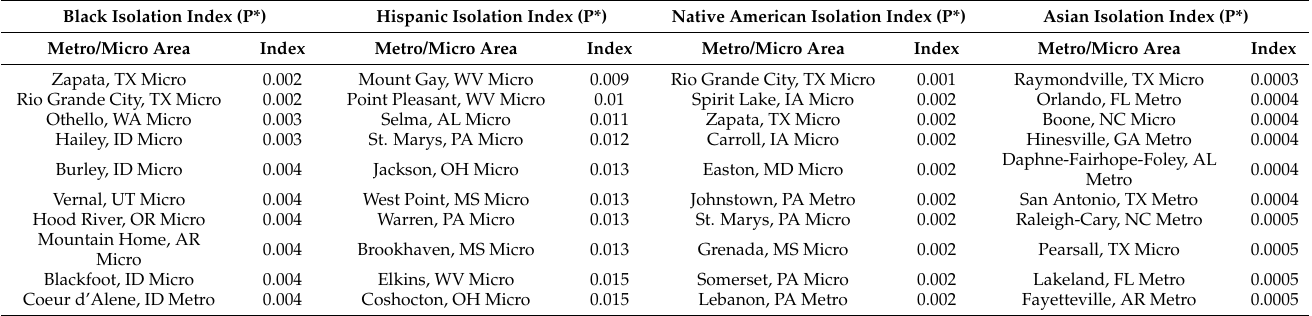
Table 8. Ten Lowest Metro/Micro Areas for Black, Hispanic, Native American, and Asian Isolation Indices